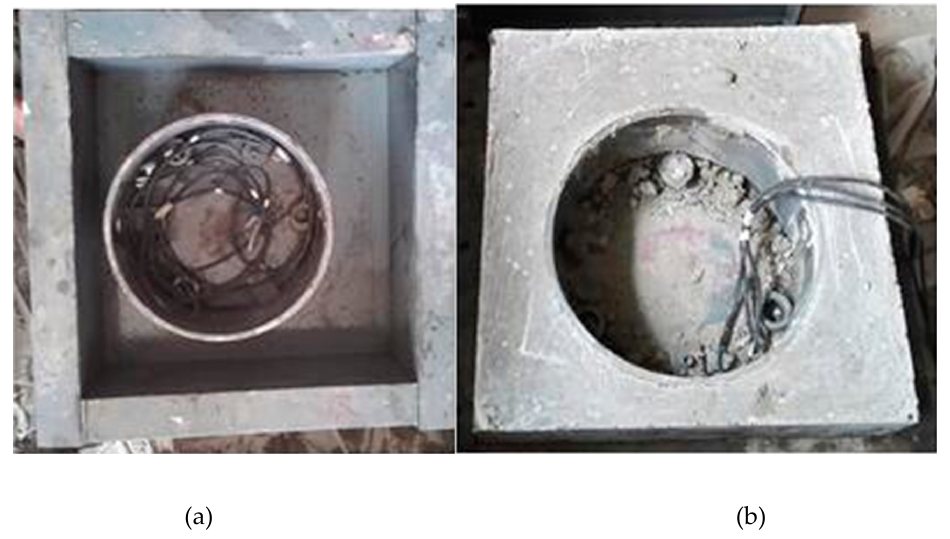
Figure 3. Test specimen of RSERST. ( a ) RSERST molds; ( b ) RSERST specimen.